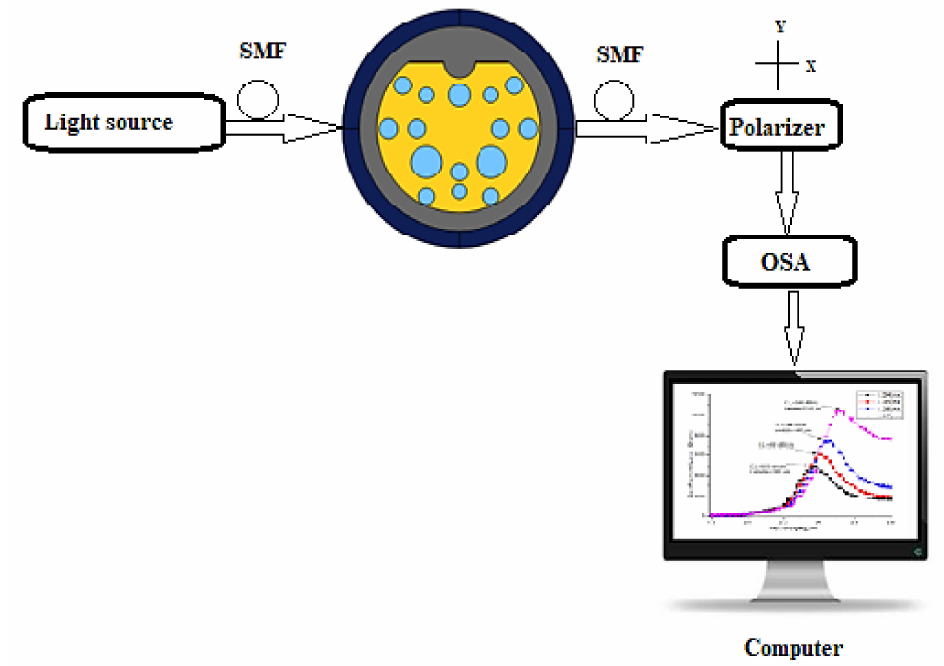
Figure 15. Experimental arrangement for the proposed reconfigurable D-shaped SPR